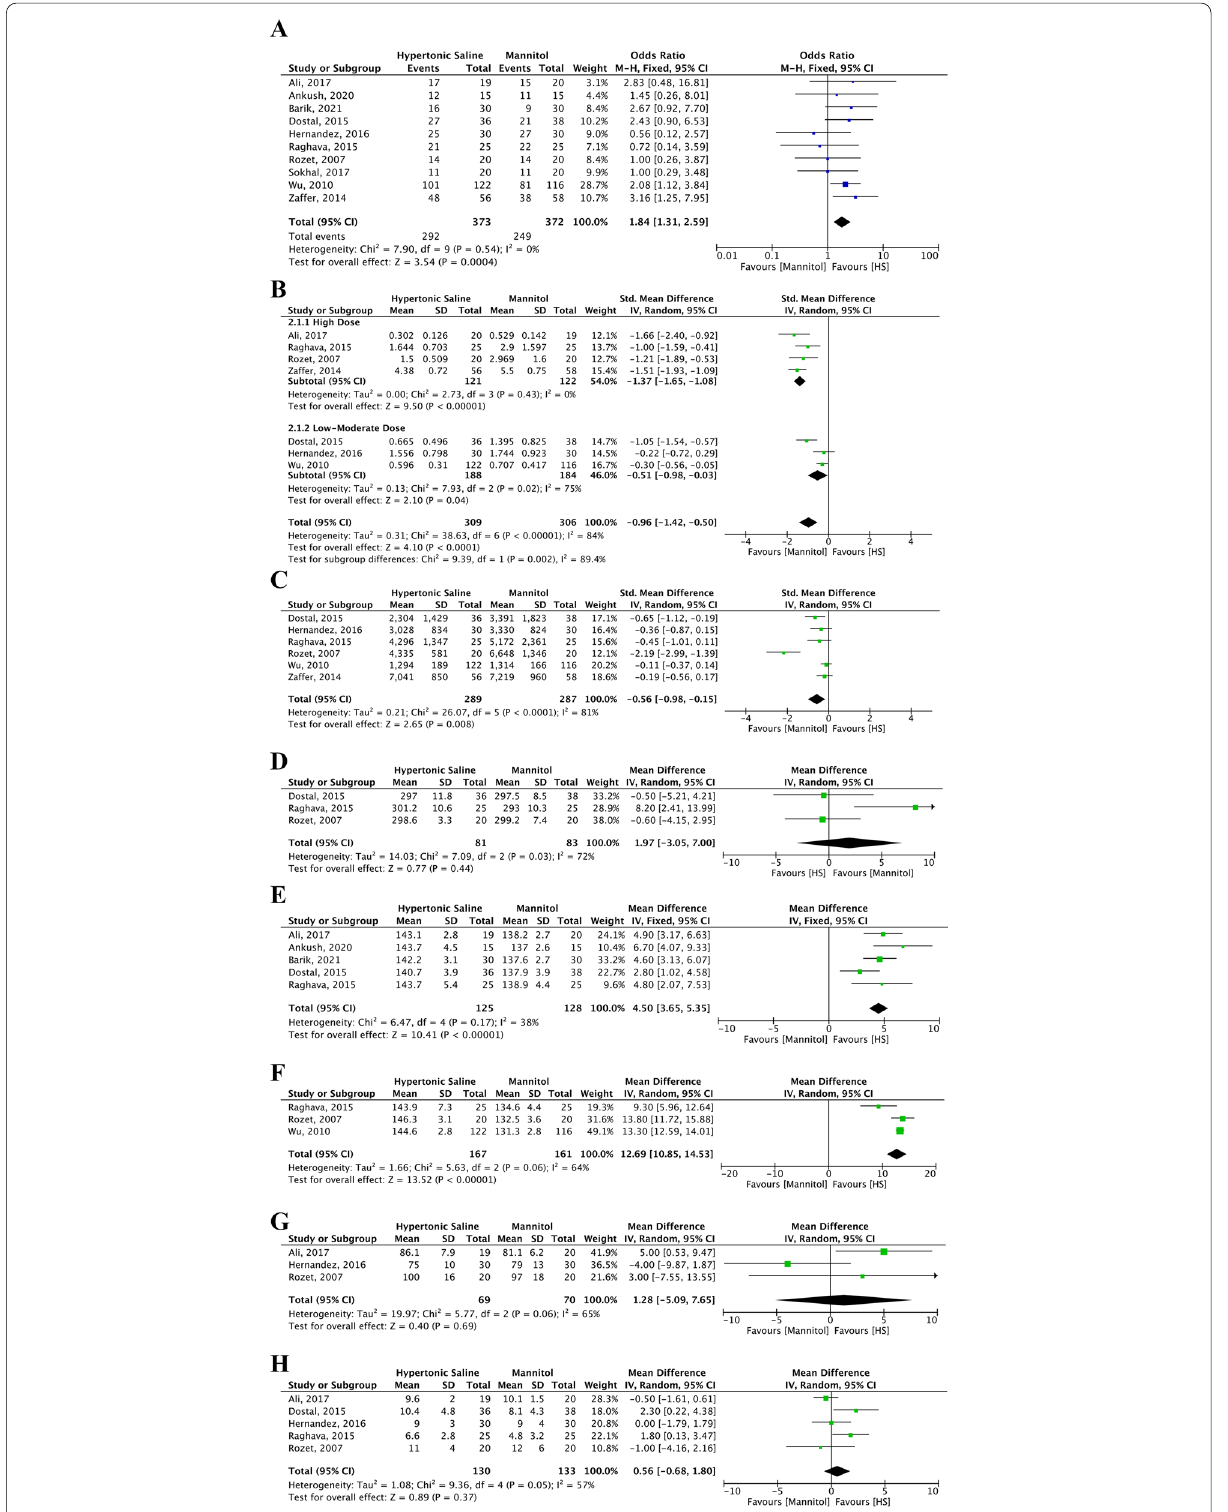
Fig. 3 A Brain relaxation, B urine output, C fluid input, D serum osmolality, E serum sodium level, F arterial blood sodium level, G max MAP, H max